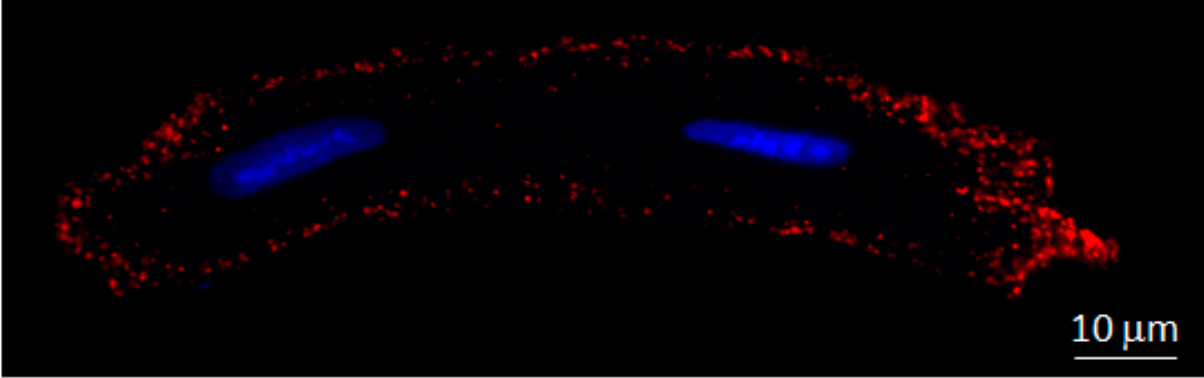
Figure 6. Confocal fluorescent image of a proximity ligation assay (PLA; Duolink) showing interaction of Cx43 with mitochondrial respiratory complex II at subsarcolemmal mitochondria. Nuclei were stained with Hoechst 33642 (blue).